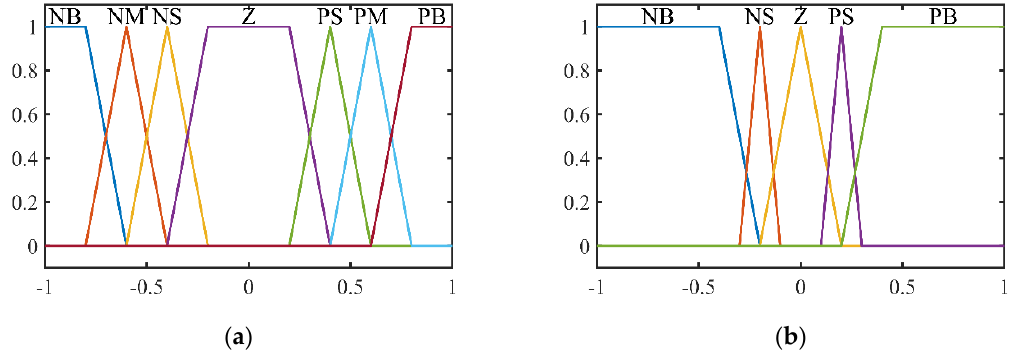
Figure 6. Membership functions of ( a ) estimated speed ˆ ω and ( b ) speed error e = ω − ˆ ω